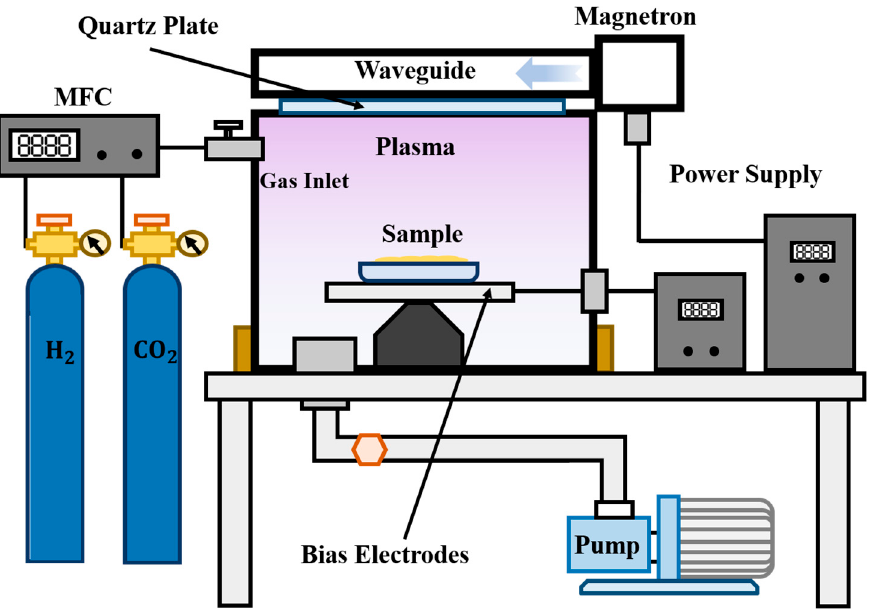
Figure 9. Setup of the microwave plasma equipment capable of joint H 2 +CO 2 plasma treatment.